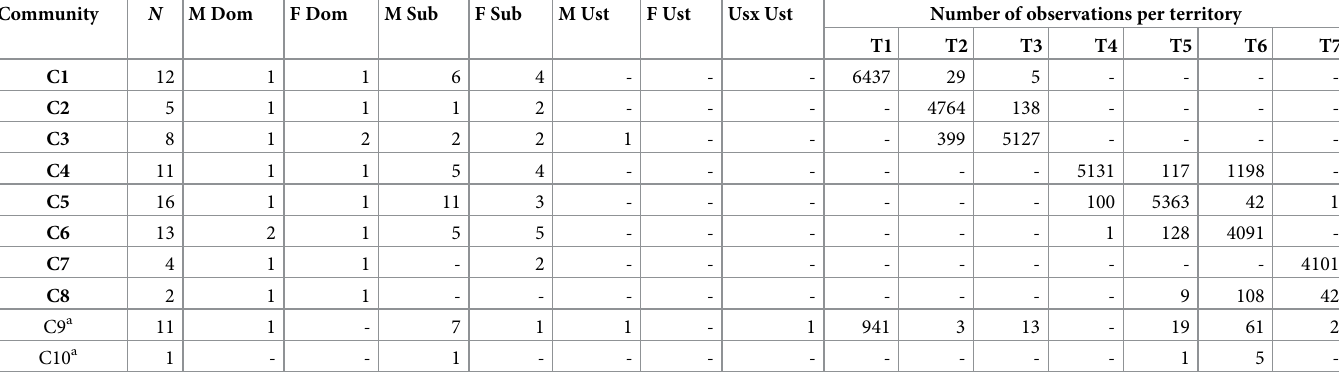
Bold communities indicate those with high-confidence membership. Observations include both true- and self-associations. M = male, F = female, Usx = unknown sex, Dom = dominant, Sub = subordinate, Ust = unknown social status.